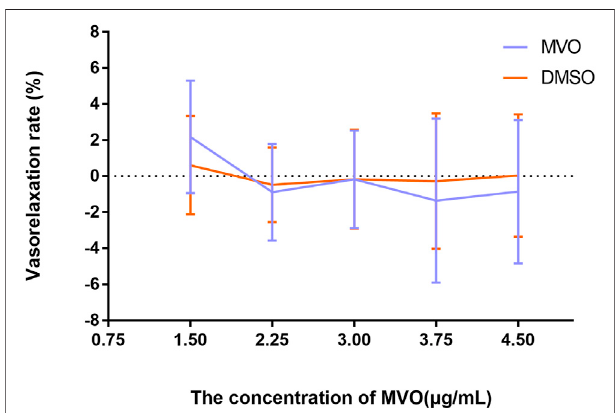
FIGURE 3 | Effects of MVO (1.5, 2.25, 3, 3.75, and 4.5 μ g/ml) on thoracic aortic rings with 1 g resting tension. n = 6. Means ± S.D. * p < 0.05, ** p < 0.01 vs. DMSO